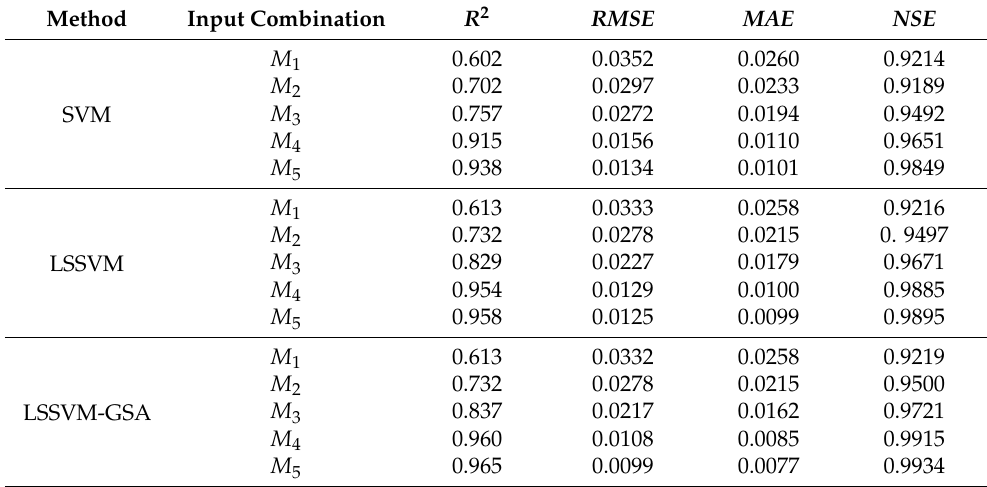
Table 5. Performance metrics for estimating C d using different input combinations (Table 3) for the testing